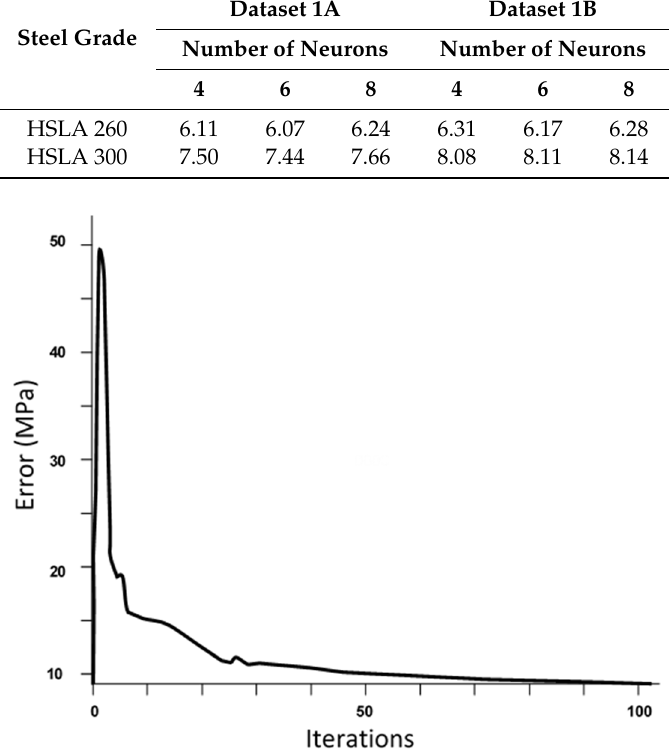
Table 6. Study of the error (MPa) with a different number of perceptrons.